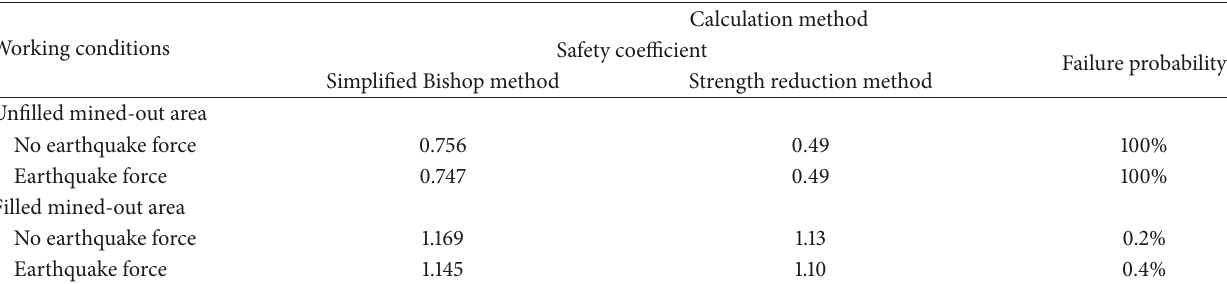
Table 4: The slope stability safety factor and probability of slope failure under different working